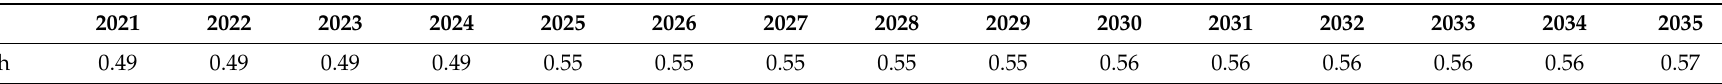
Table 18. Projected savings resulting from the implementation of the project [PLN]. Source: designed by authors.